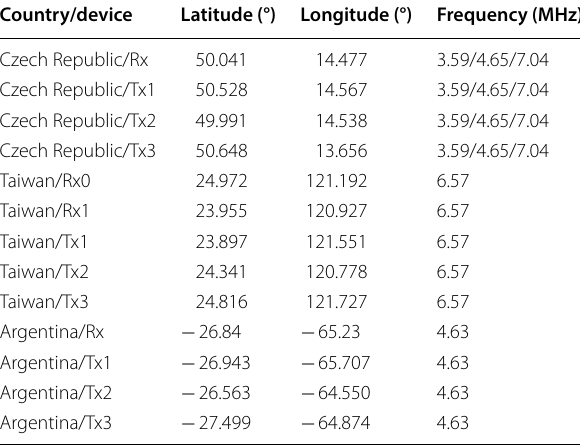
Table 1 Coordinates of transmitters (Tx) and receivers (Rx) Country/device